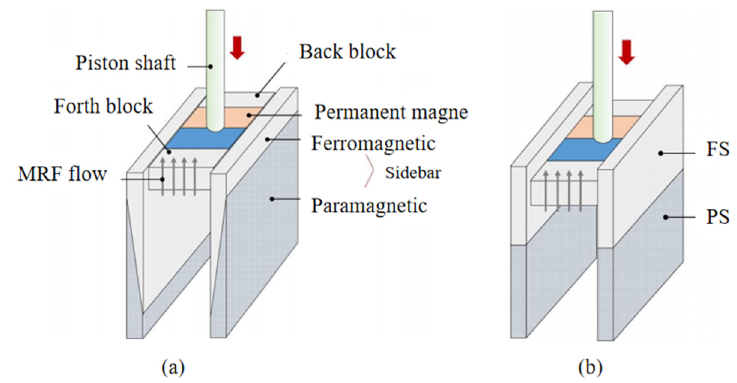
Figure 7. New permanent magnet-based MRDs [51,52]: ( a ) Triangular column sidebar. ( b ) Rectangular column sidebar.